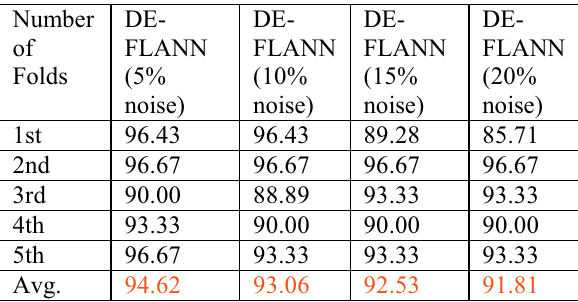
Table 3: Results Obtained From DE-FLANN for Iris